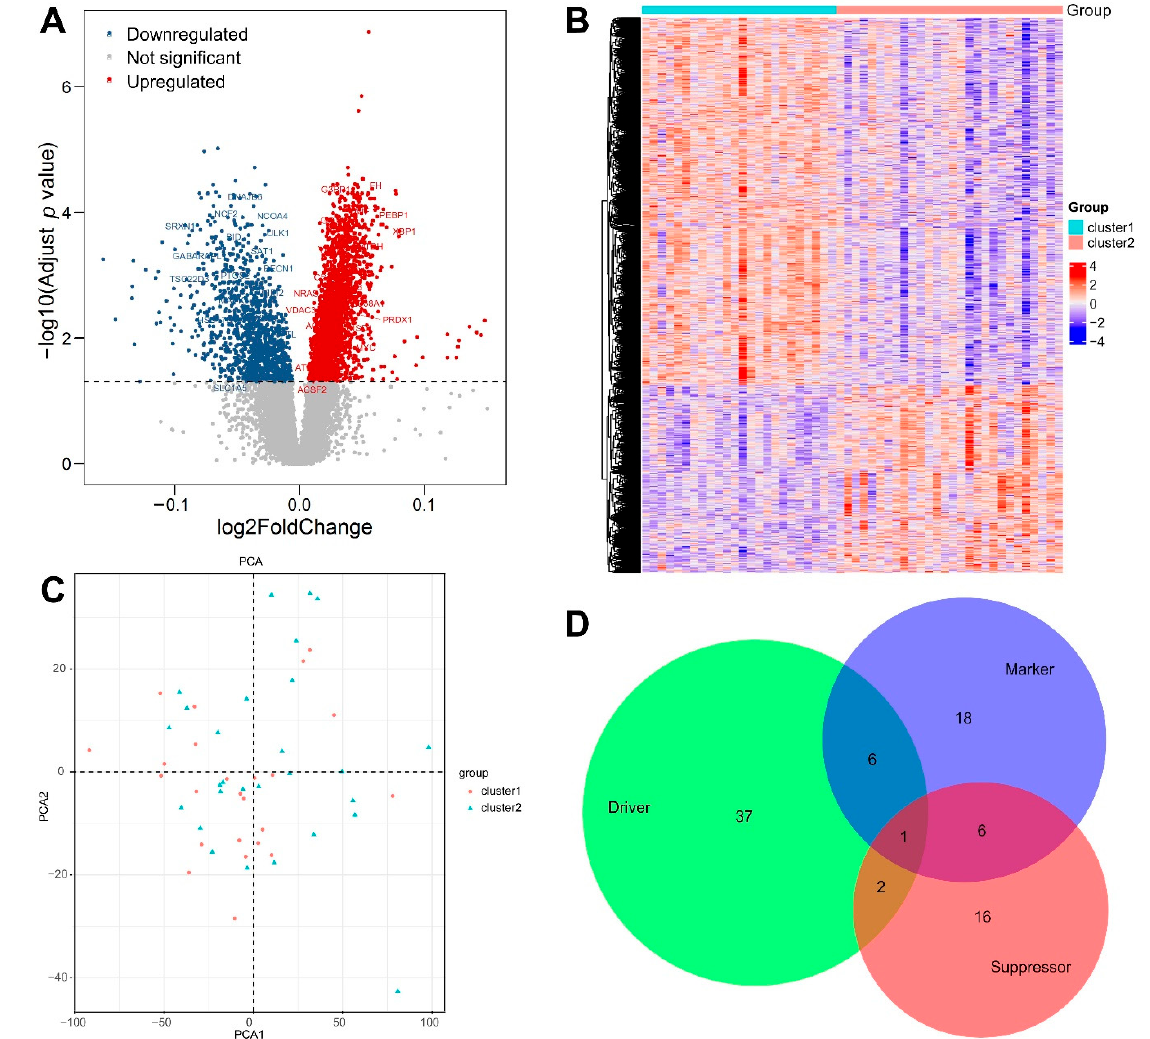
Figure 4. ( A ) Volcano plot of the differentially expressed genes between the two clusters, with some frequently reported ferroptosis-related genes being labeled. The cut-off adjusted p -value was <0.05. ( B ) Heatmap of the differentially expressed genes between the two clusters. Red indicates high expression and blue indicates low expression. ( C ) Scatter plot of the principal component analysis (PCA). The X -axis and Y -axis refer to the first and second principal components, respectively. ( D ) Venn diagram of the 86 differentially expressed ferroptosis-related genes between the two clusters, with annotations from the FerrDb database.